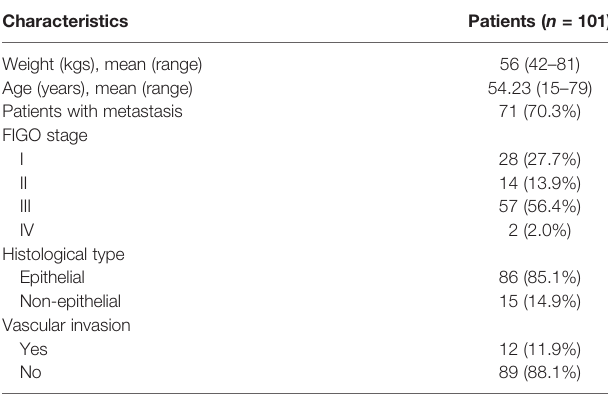
FIGO, International Federation of Gynecology and